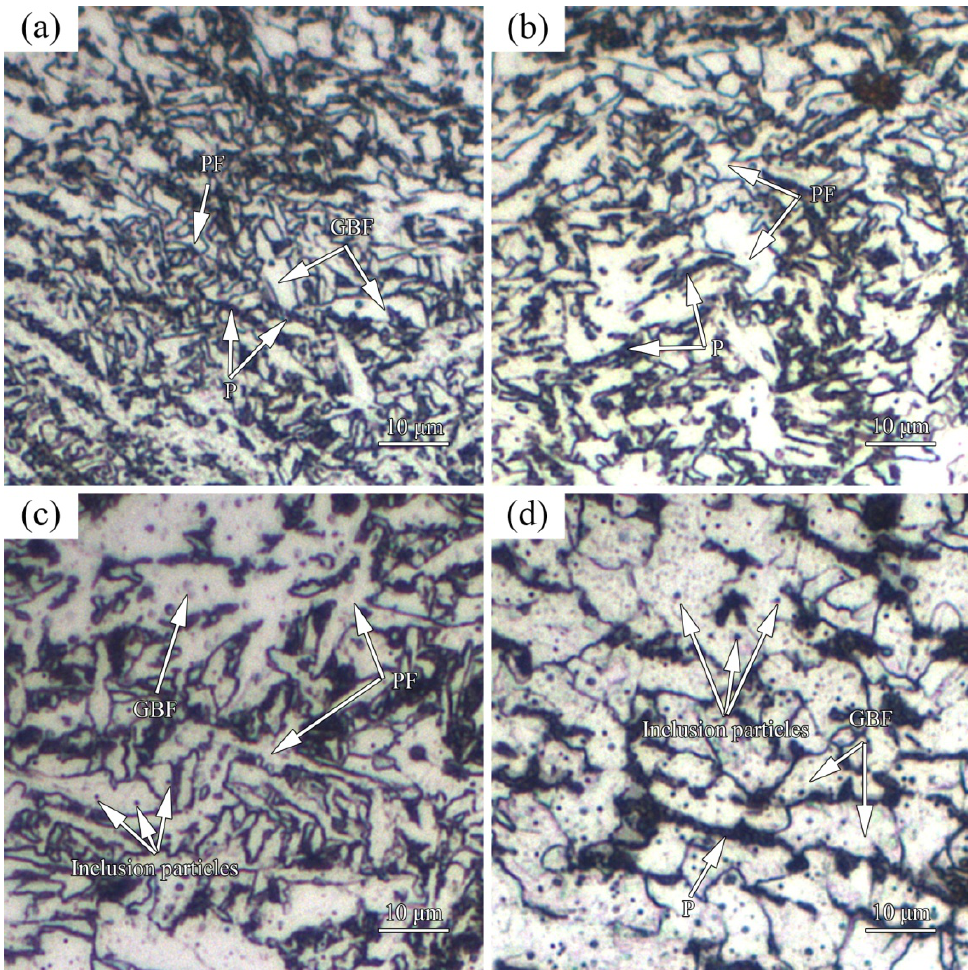
Figure 5. Microstructure morphology of the CPF zone for different samples after LSM-CPF process treatment: ( a ) sample 3; ( b ) sample 4; ( c ) sample 5; ( d ) sample 6.